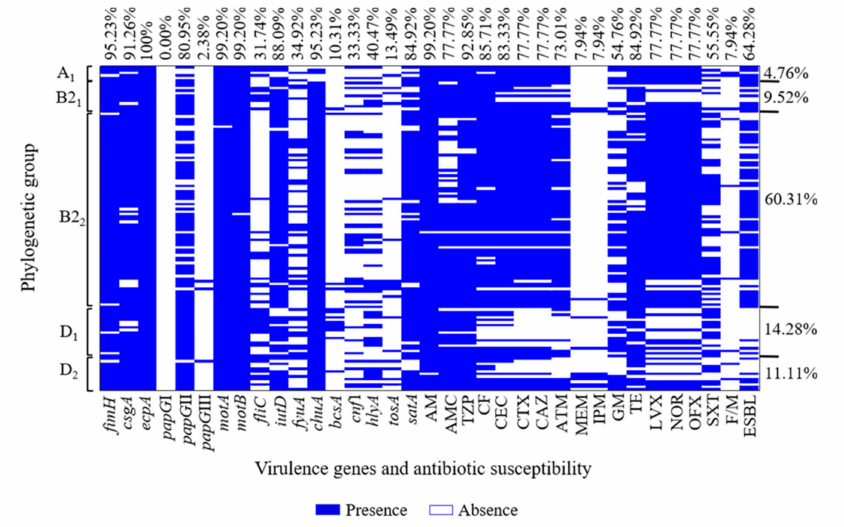
Figure 1. Heat map of virulence genes and antibiotic resistance profiles associated with UPEC O25b strains. Clinical strains of UPEC showing five phylogenetic subgroups: 17 virulence genes ( fimH , csgA , ecpA , papG I, papG II, papG III, fliC , motA , motB , iutD , fyuA , chuA , bcsA , cnf1 , hlyA , tosA , and satA